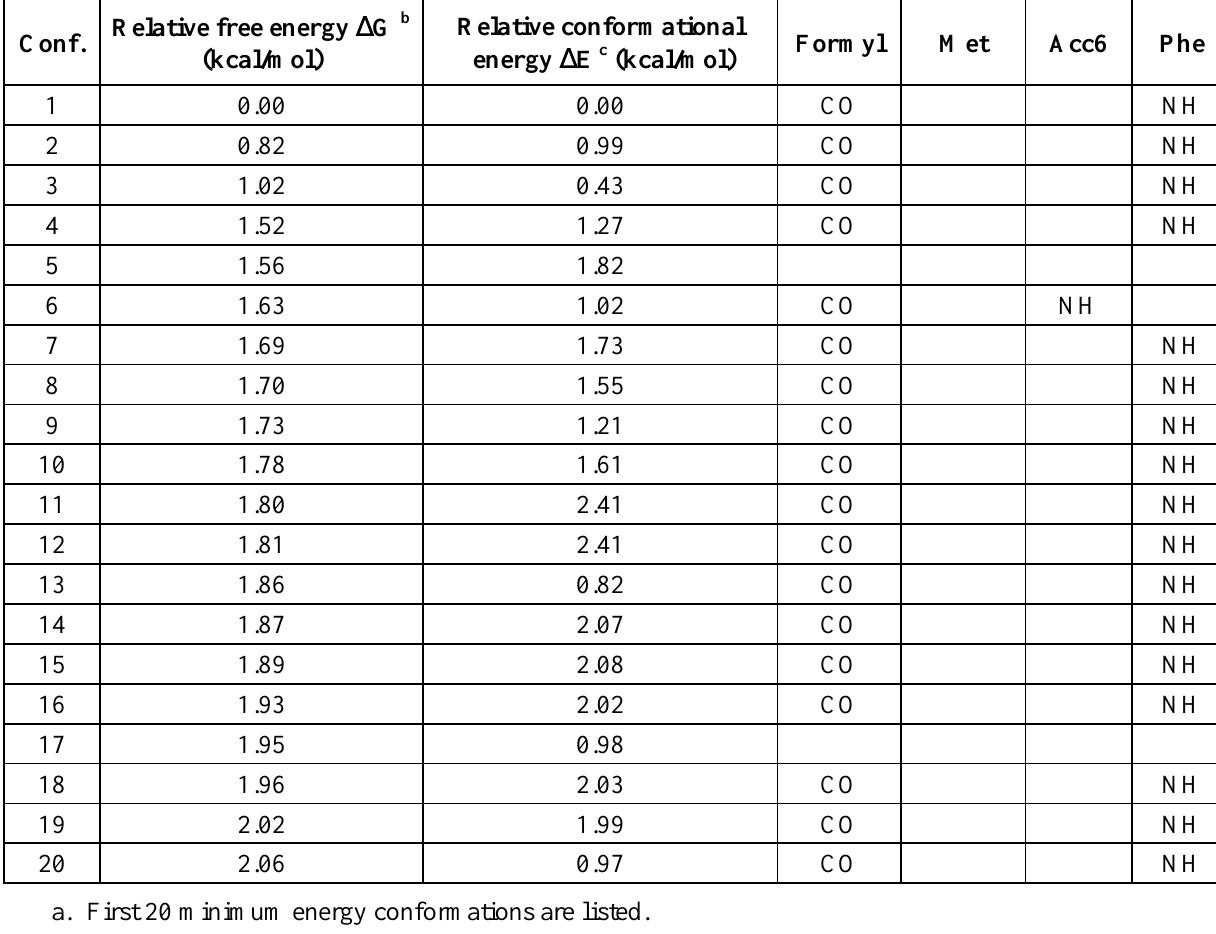
Table 2. Conformational characteristics of formyl-Met-Acc6-Phe-OMe a . Conf.